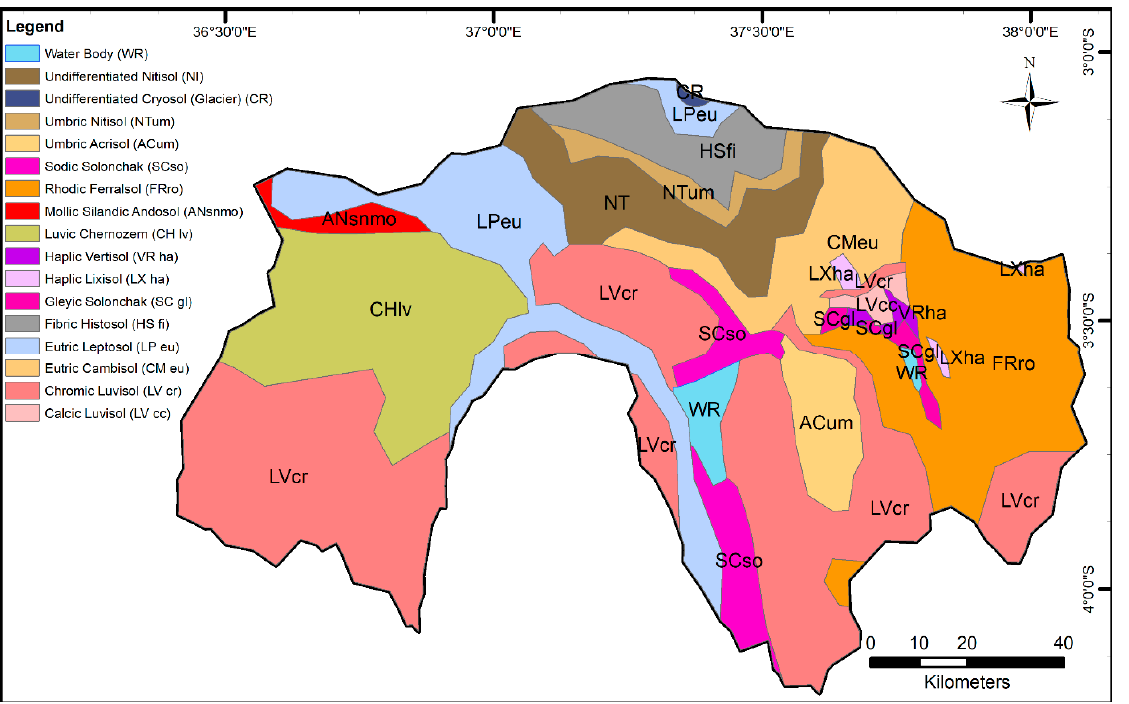
Figure 1. The map of the Upper Pangani Basin details the major soil types in the catchment [40].